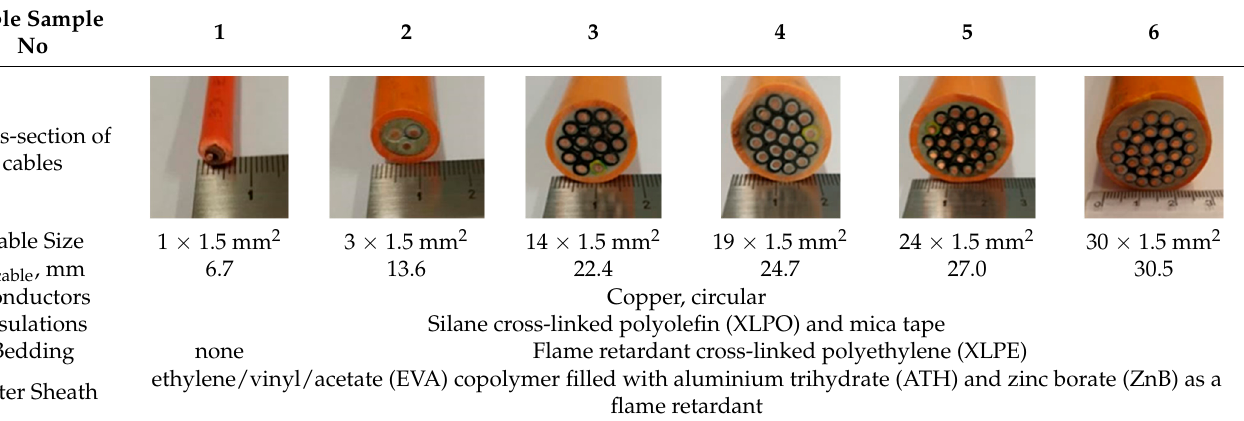
Table 1. Characteristics of cable samples.